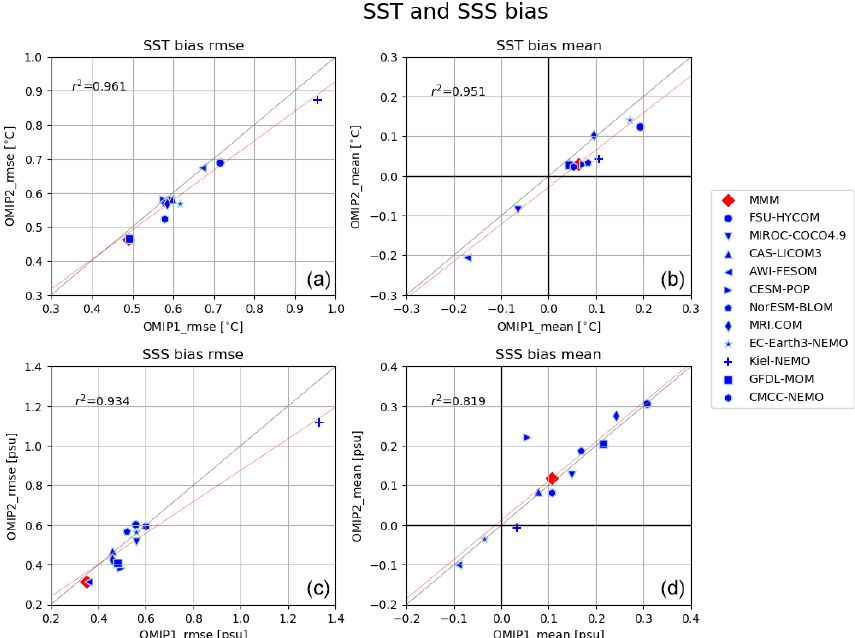
Figure 27. Scatter diagram with linear fitting (red line) and its score ( r 2 ) comparing the 30-year mean (1980–2009) SST bias RMSE (a) , SST bias mean (b) , SSS bias RMSE (c) , and SSS bias mean (d) from OMIP-1 (abscissa) and OMIP-2 (ordinate). See Table D3 for specific values.